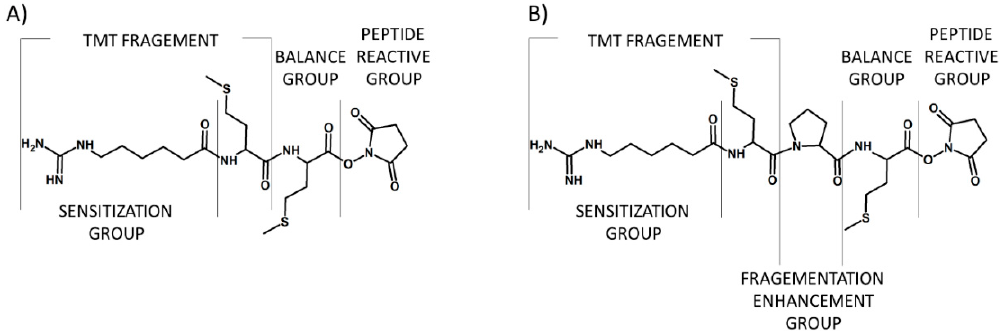
Figure 4. First ( A ) and second ( B ) generation of tandem mass tags developed by Thomson and co- co-workers workers [14].